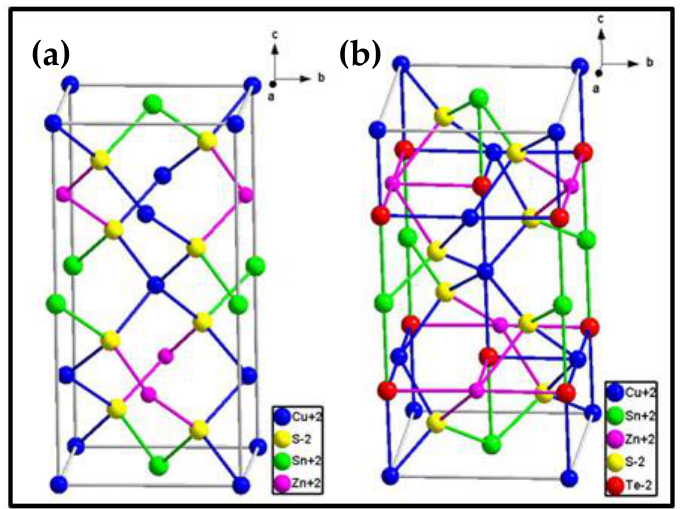
Figure 4. Simulated crystal structures of ( a ) CZTS and ( b ) CZTSTe (blue = Cu; green = Sn; pink = Zn; red = Te; yellow = S). Table 1. Crystal parameters.